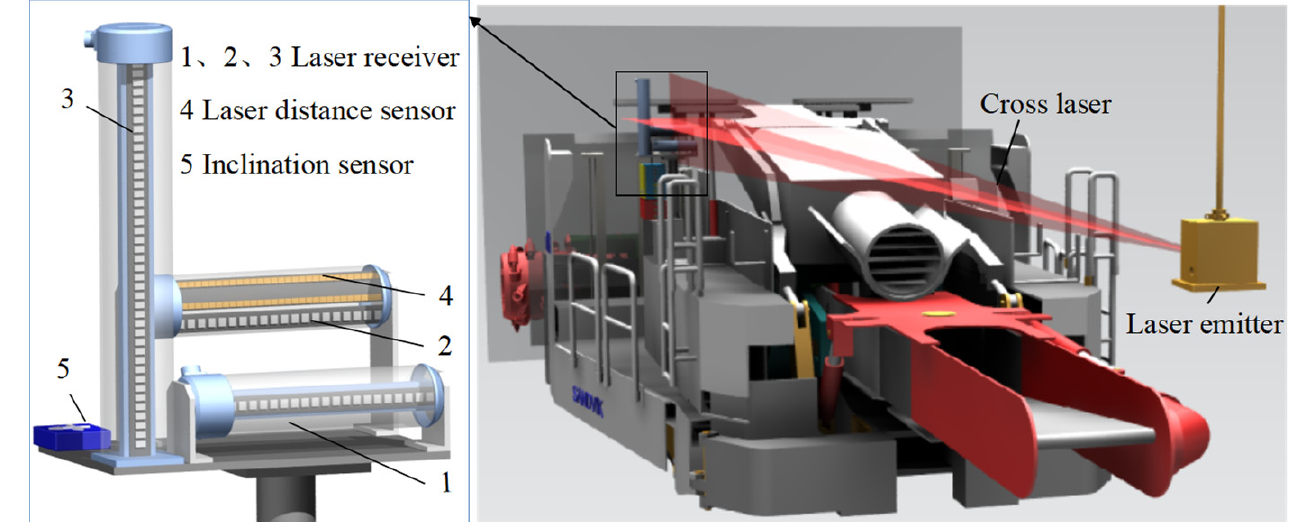
Figure 1. Pose detection method.